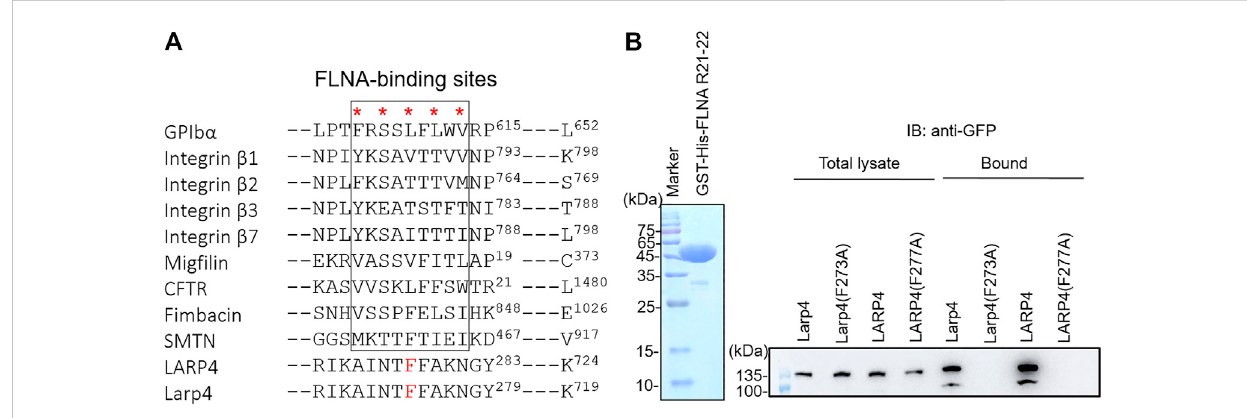
FIGURE 4 Identi fi cation ofcriticalamino acidsof LARP4 for FLNA interaction. (A) Alignment of bindinginterfacesof FLNA-binding partners. Point mutations of theunderlinedaminoacidsofmouseLarp4(F273)andhumanLARP4(F277)toAlawerepredictedtodisrupttheinteractionwithFLNAR21. (B) GFP-LARP4 (Larp4) (WT, F277A in LARP4 and F273A in Larp4) were expressed in HEK293A cells. Cell lysate were mixed with GST-His-FLNA R21-22 immobilized on glutathione beads. CBB staining showed 2 μ g of the puri fi ed Gst-His-FLNA R21-22 protein loaded to the 15% SDS-PAGE gel. Bound GFP- LARP4(Larp4) was detected by western blotting using anti-GFP antibodies.